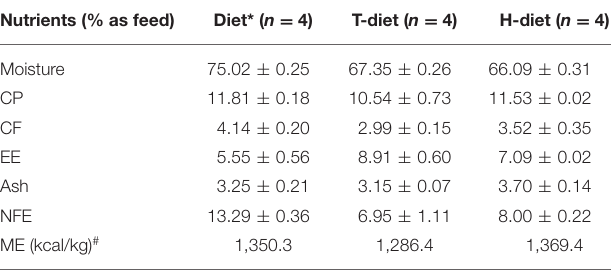
TABLE 2 | Fatty acid profiles (% of total fatty acids) of tested diets. Fatty acids Diet*